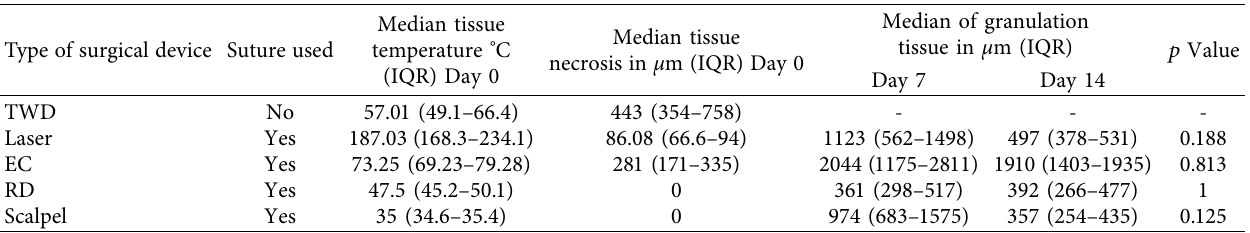
Table 3: Thermoeffect of various surgical devices on the tissue on experimental day 0 and granulation tissue on day 7 and day 14. Type of surgical device Suture